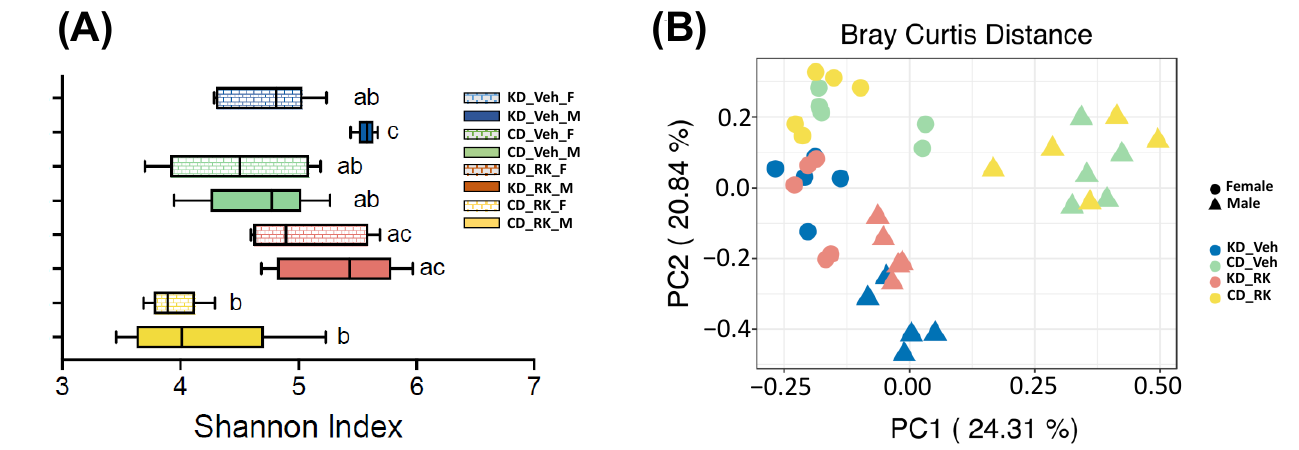
Figure 4. Effects of daily raspberry ketone dosing and diets feeding on gut microbiota. ( A ) Alpha diversity plot using Shannon Index. The different letters a, b, and c indicate statistical significance; the Kruskal-Wallis test, followed by Dunn’s post hoc test, was applied to compare the groups. Boxes showed the medians and the interquartile ranges (IQRs), the whiskers denoted the lowest and highest values that were within 1.5 times the IQR from the first and third quartiles, and outliers were shown as individual data points. N = 5 for each group. vehicle, Veh; raspberry ketone, RK; high-fat diet (45%fat), HFD; ketogenic diet (80%fat), KD; low fat control diet (10%fat), CD; male, M; female, F. ( B ) Principal coordinates analysis plot of beta diversity based on the Bray-Curtis distance. N = 5 mice/each group.